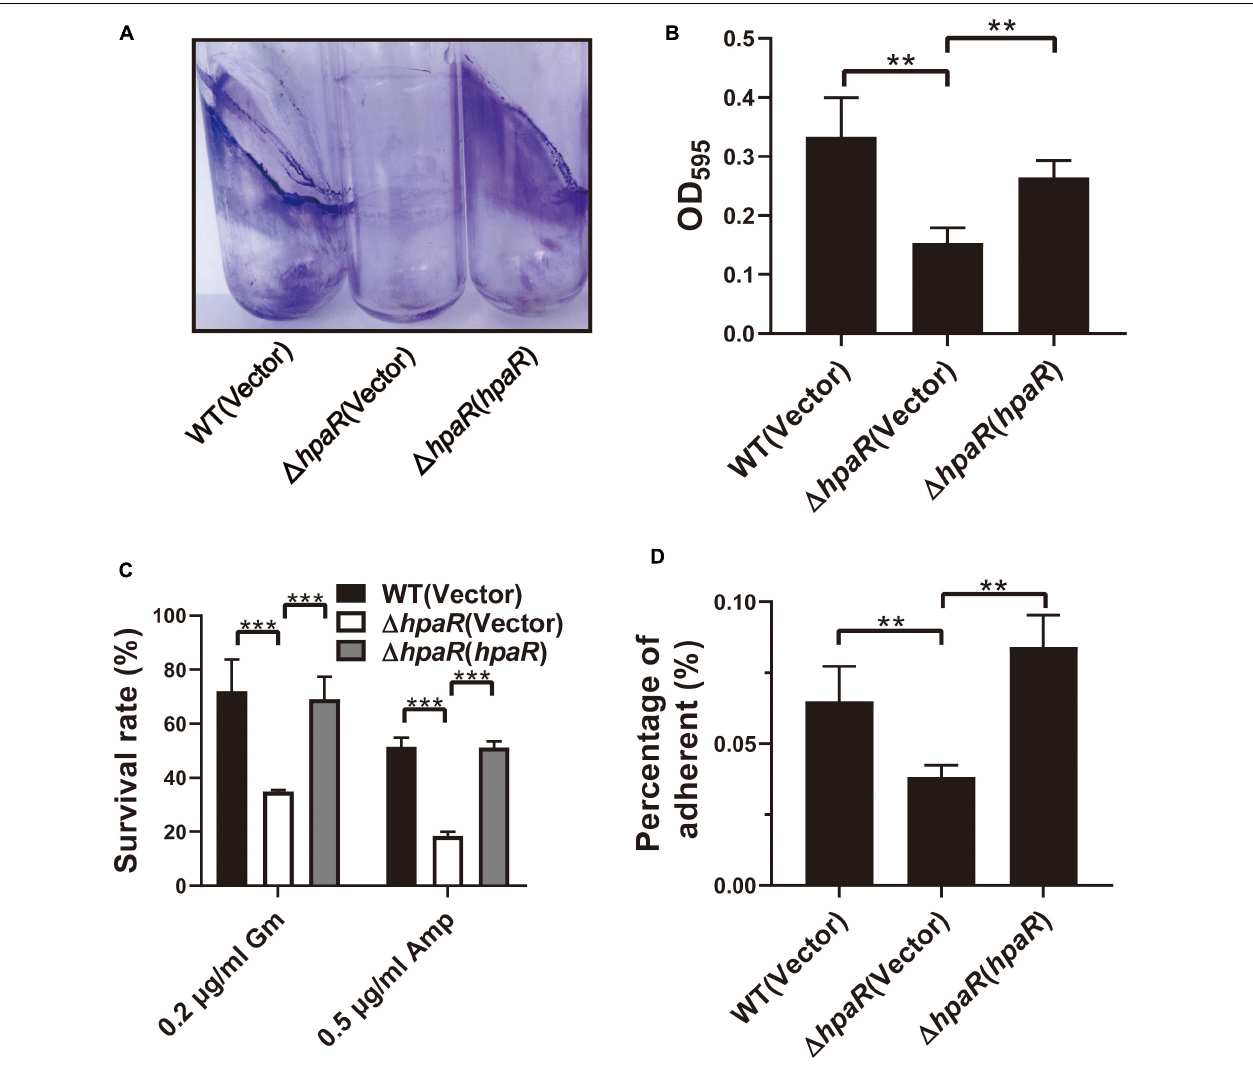
FIGURE 5 | HpaR is involved in biofilm formation, antibiotic resistance and adhesion to eukaryotic cells. (A) Direct observation of Y. pseudotuberculosis biofilm formation by Wild-type, (cid:49) hpaR mutant, and its complementary strain (cid:49) hpaR ( hpaR ). The results shown the biofilm biomass stained with crystal violet in glass test tubes. (B) Quantitative measurement of biofilm formation by resolving in 95% ethanol and measuring the absorbance at OD 595 . (C) The survival rate of Wild-type, (cid:49) hpaR mutant, and its complementary strain (cid:49) hpaR ( hpaR ) under 0.2 µ g/ml gentamicin (Gm) or 0.5 µ g/ml ampicillin (Amp) treatment. (D) Adhesion of the strains to HeLa cells. Adherence level is expressed as the percentage of adherent bacteria relative to the inoculum count. Data shown are the average of three independent experiments; the error bars indicate the standard deviation from three independent experiments. *** P < 0.001; ** P < 0.01; * P < 0.05; n.s., not